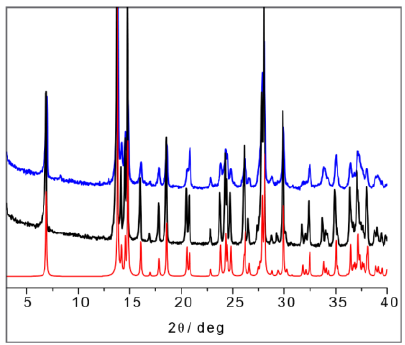
Figure 9. From bottom to top: calculated pattern from single-crystal data of IWOFUX (L-Arg·Ag) in red), experimental powder pattern of L-Arg·Ag (in black), and experimental powder pattern.